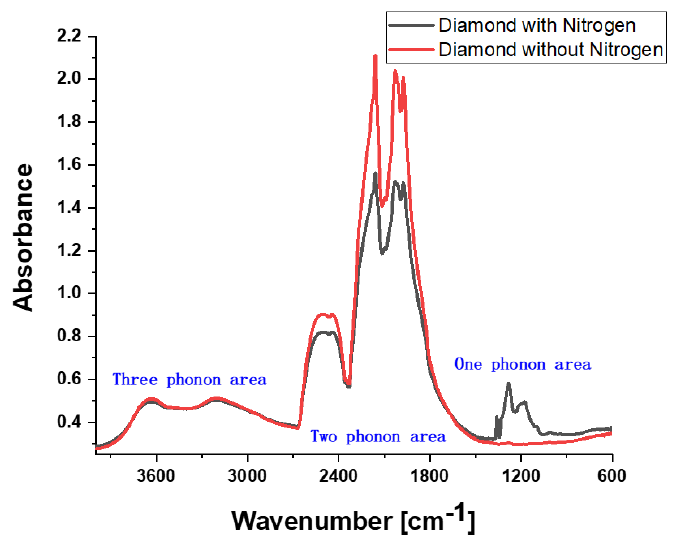
Figure 1. Example of IR spectra of diamonds with and without nitrogen contamination in the range of 600–4000 cm − 1 (marked in the figure are the three phonon areas).